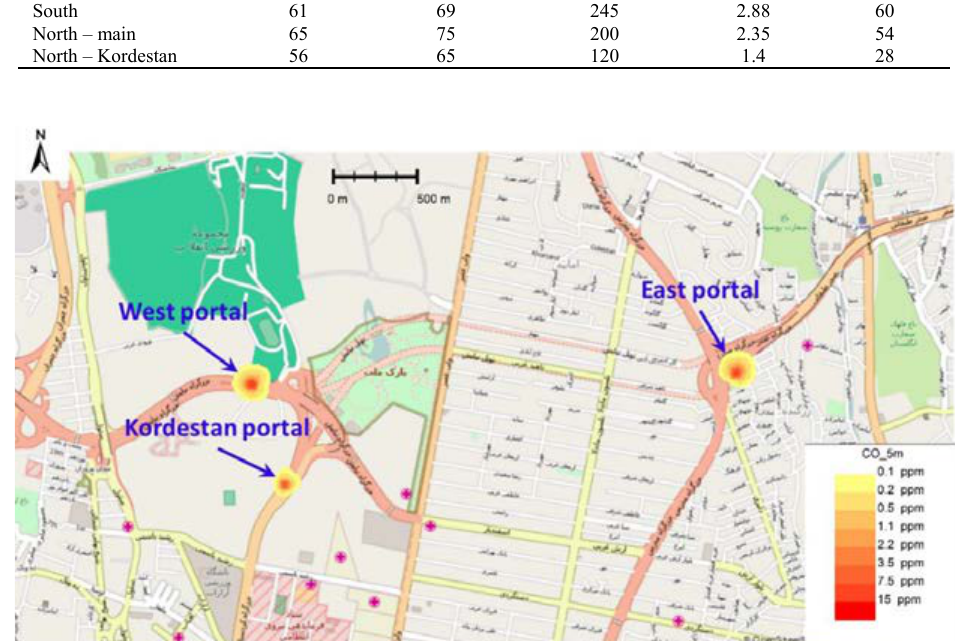
Table 1: Emitted CO from the portals–congestion traffic (Rafiei, 2016) Tunnel Portal